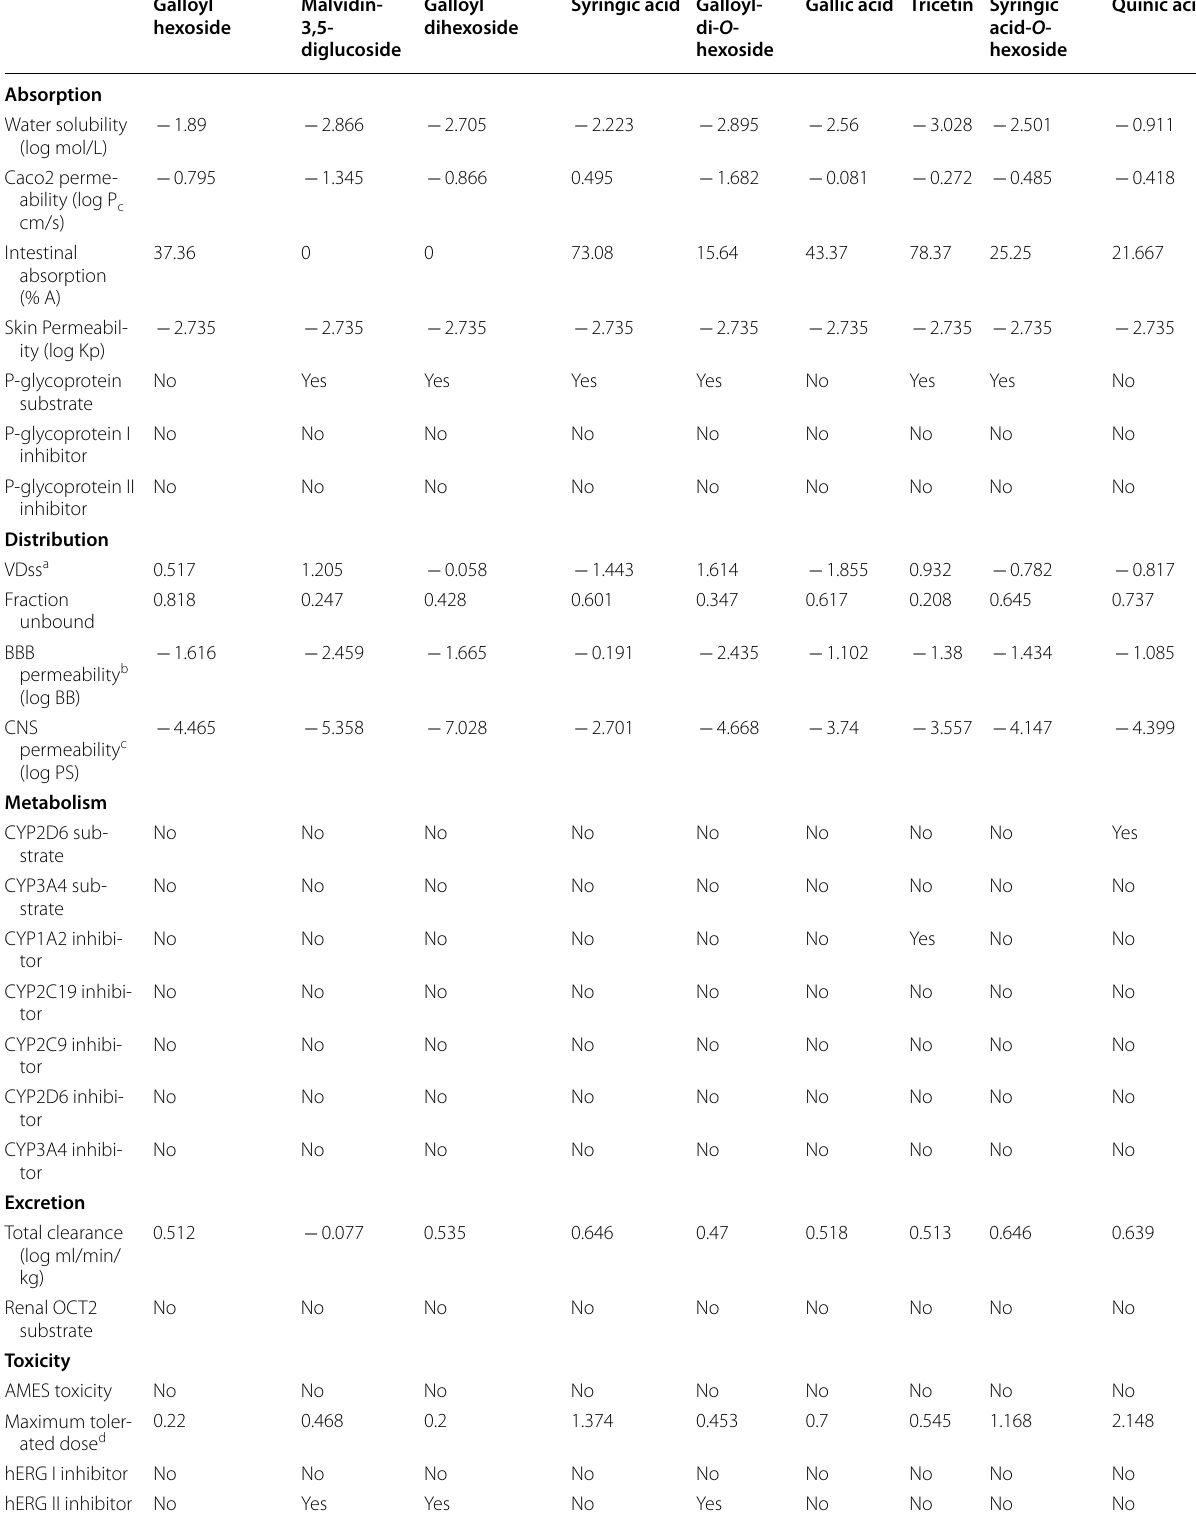
Table 3 The ADMET parameters of polyphenols from R. coriaria via pkcsm software